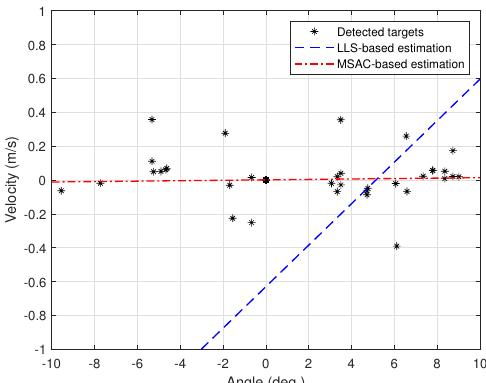
Figure 10. Estimation result: velocity ranges from − 1 m/s to 1 m/s (same data as Figure 9a, but reduced velocity